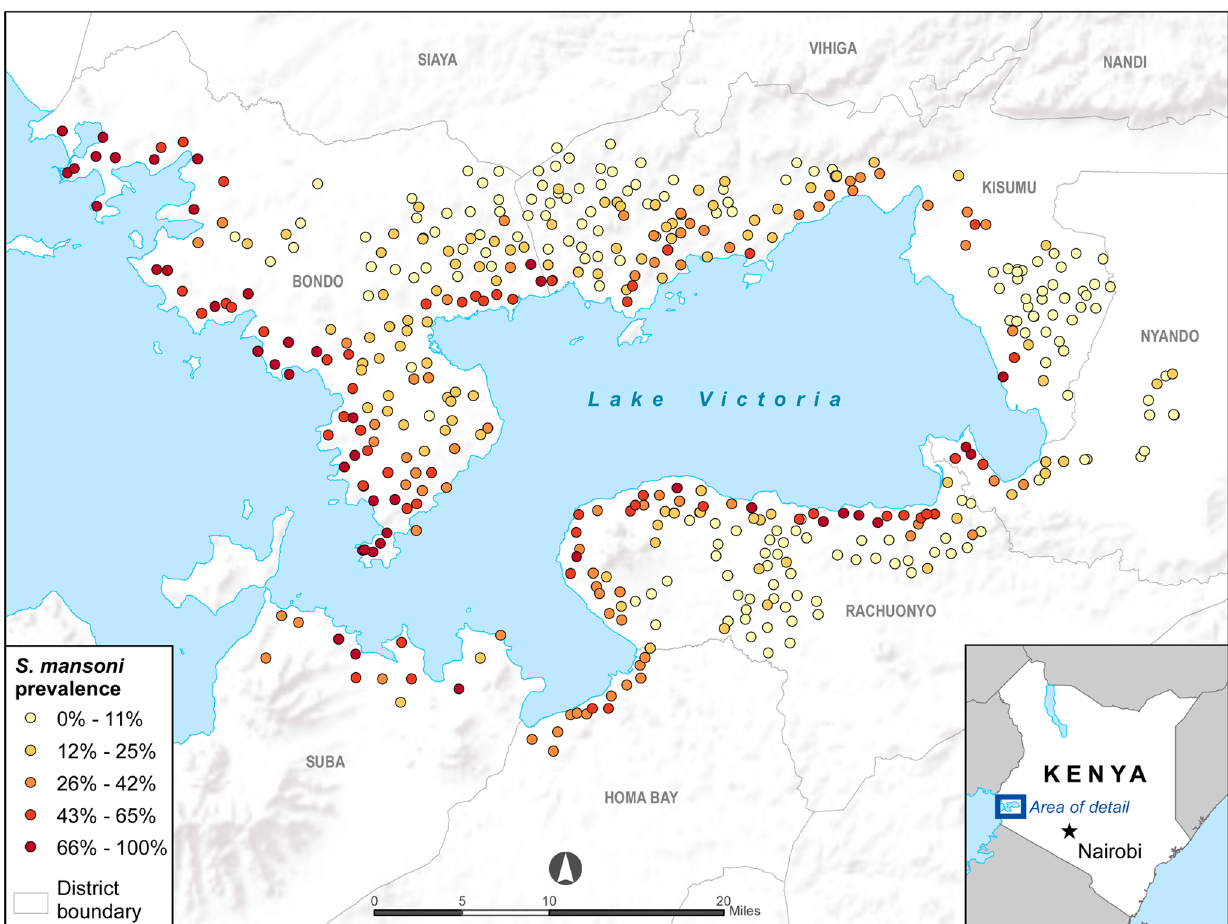
Figure 1. S.mansoni prevalence in selected primary schools in Nyanza Province, Kenya.